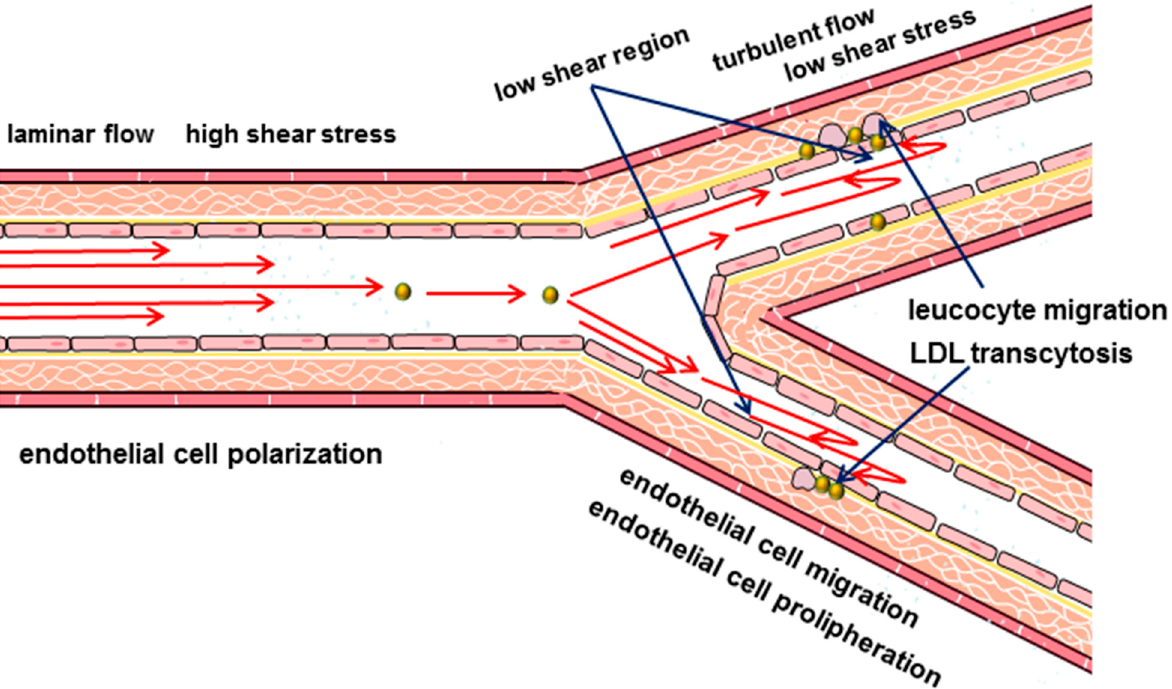
Figure 1. Scheme of hemodynamics in arterial bifurcation. Regions with low shear stress are associated with the development of atherosclerosis.